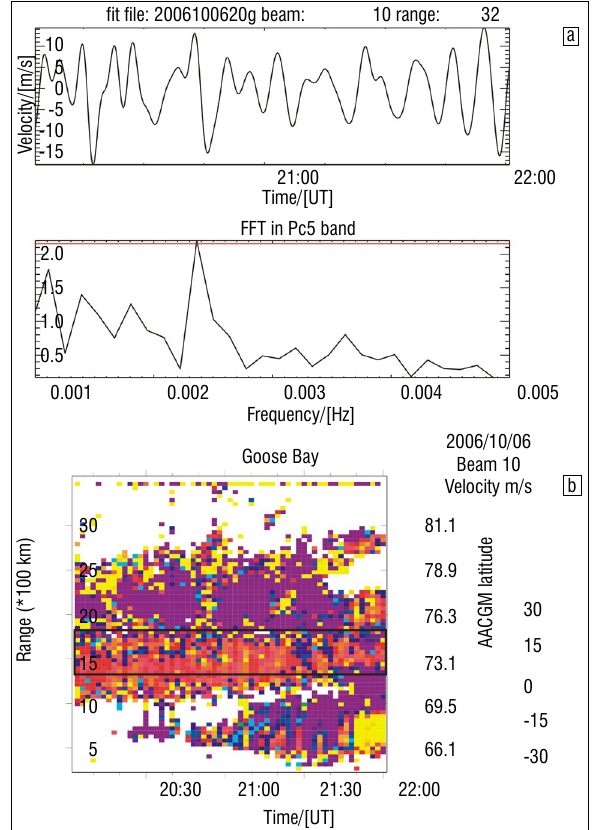
(a) The top panel shows Pc5 band filtered data and the bottom shows the corresponding power spectrum and the significant limit level from filtered data. The peak detector recorded the peak in frequency band 2.2–2.5 mHz as significant. (b) A time–range summary plot of Doppler velocity measured by beam 10 showing range gates and altitude-adjusted corrected geomagnetic (AACGM)